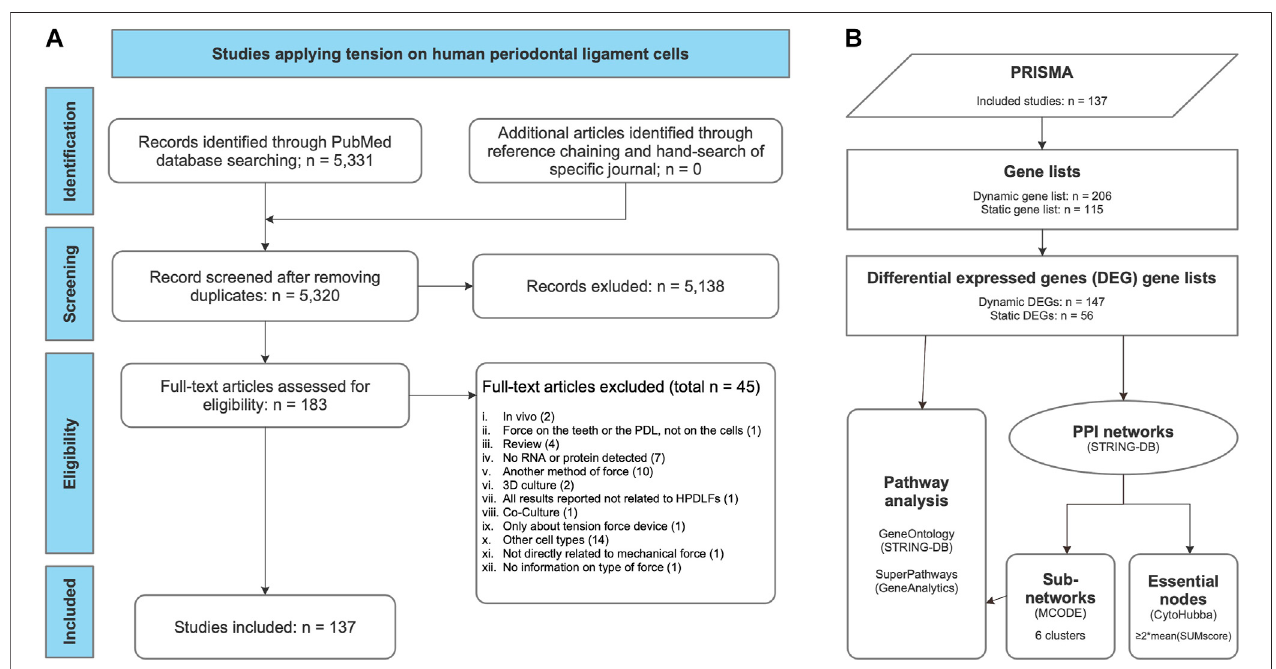
FIGURE 3 | Work fl ows applied in this systematic review. (A) PRISMA fl ow diagram for the whole process of study selection according to Moher et al. (2009). (B) Gene set enrichment and network analysis of gene lists derived from the review process. Gene lists were compiled, listing the examined genes, proteins or metabolites studied either after dynamic or static tension application ( Table 3 , Supplementary Table S2 ). From these, differential expressed gene (DEG) lists were generated accordingtothespeci fi edcriteria( Table4 ).ForeachofthesetwoDEGlists(dynamicDEG,staticDEG)protein-proteininteraction(PPI)networkswereconstructed using STRING-DB (Szklarczyk et al., 2019) ( Figures 5A,B ) and pathway analysis was conducted quering “ GeneOntology/Biologcal Process ” (Ashburner et al., 2000) and GeneAnalytics ’ “ SuperPath ” databases (Ben-Ari Fuchs et al., 2016) ( Supplementary Table S8 ). Subnetworks were identi fi ed in both PPI networks using MCODE (Bader and Hogue, 2003) ( Table 4 ; Figures 5C,D ) and essential nodes, so called “ hub genes ” , using cytoHubba (Chin et al., 2014) ( Table 5 ; Figure 5